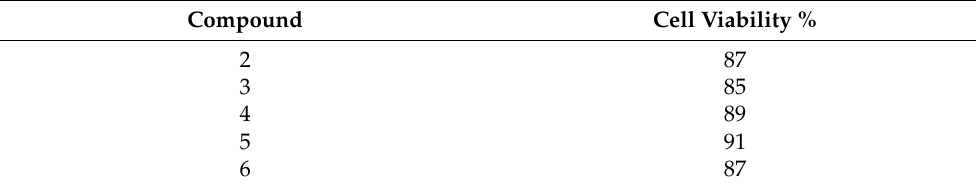
Table 4. Cell viability assay results of compounds 2–6